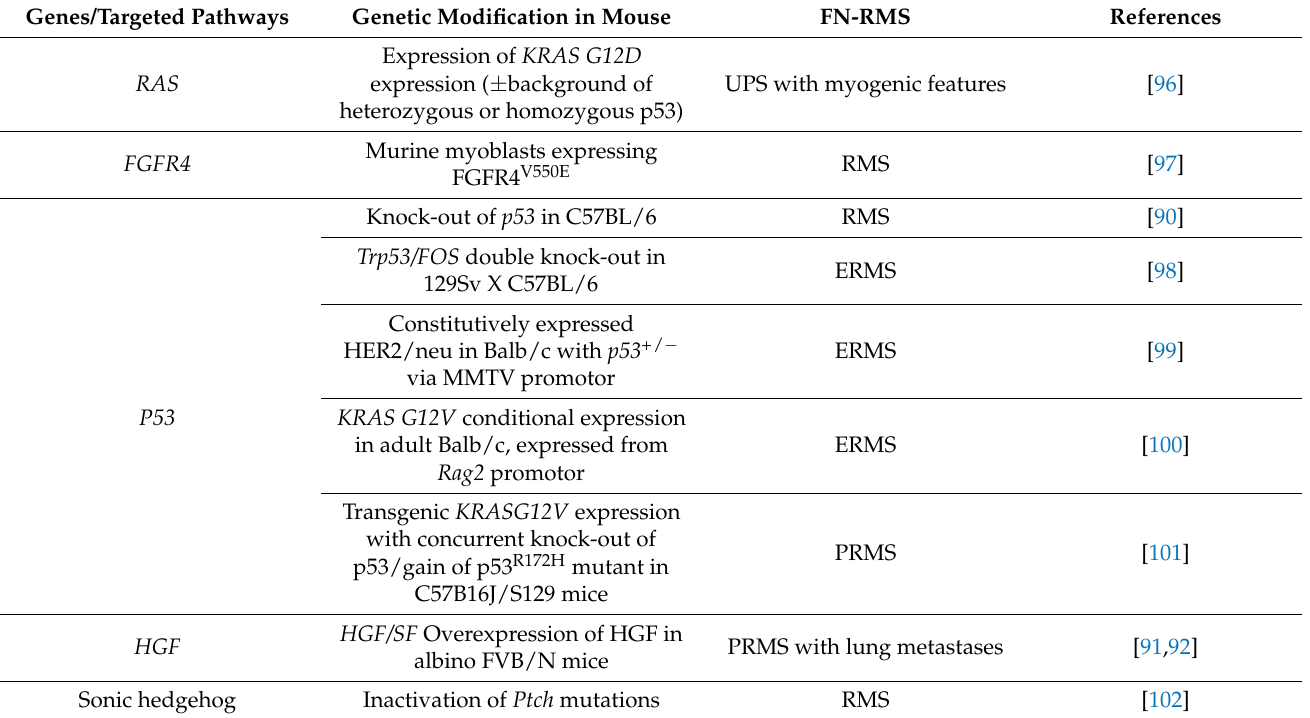
Table 1. Currently existing mouse models to study ERMS